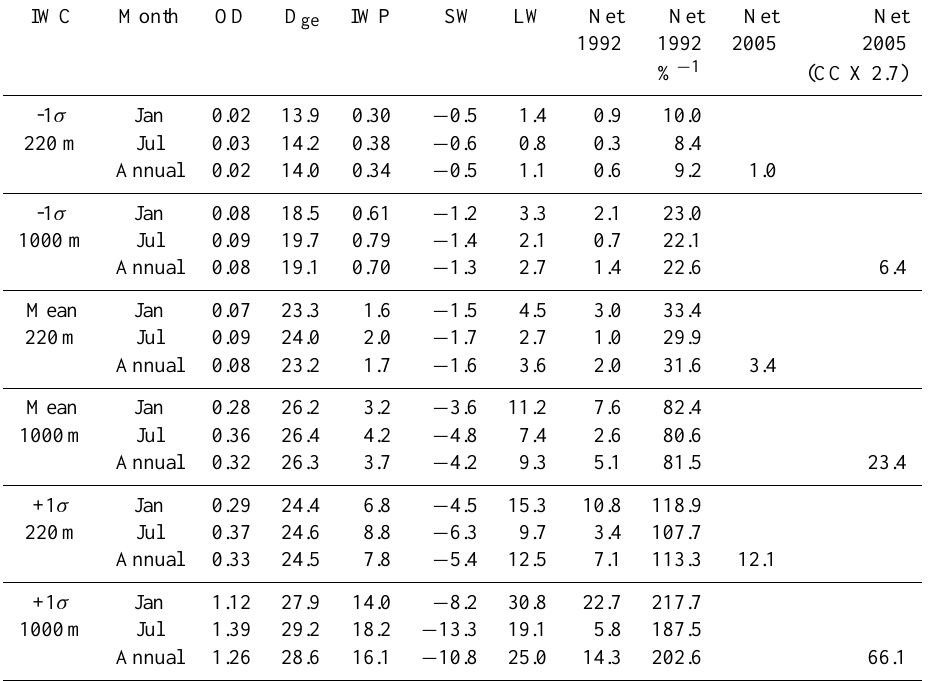
Table 1. Global mean top-of-the-atmosphere shortwave (SW), long-wave (LW), and net contrail radiative forcing (mWm − 2 ) for the three IWC assumptions (mean, upper and lower standard deviation). The weighted net RF (per % contrail cover) is also included. The annual mean global contrail cover (CC) is 0.047%, as calculated in the TRADEOFF inventory of aircraft flown distance for the year 1992 and scaled up CC values for year 2005 and a further factor of 2.7 scale up to allow for CC uncertainties. The mean optical depth (OD), generalized size ( D ge in µm), and ice water path (IWP in gm − 2 ) correspond to the NH